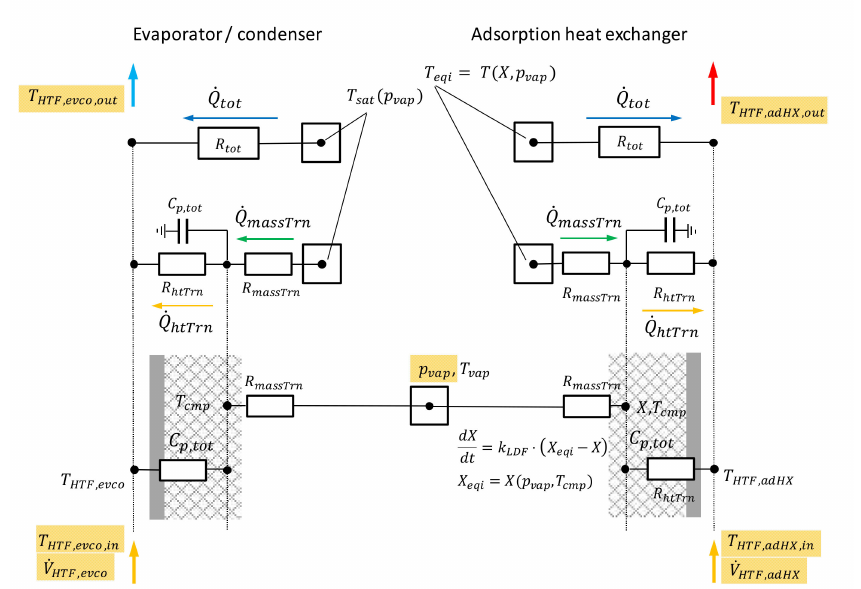
Figure 5. Above: Simple driving temperature difference model with one single resistance, middle: Driving temperature difference model with a heat- and a mass transfer resistance and a thermal capacitance, below: Heat and mass transfer resistance model for adsorption heat exchanger and combined evaporator-condenser. We measure the yellow marked state variables with our test